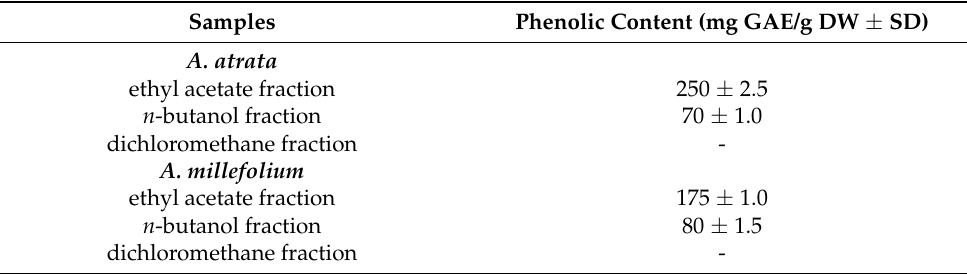
Table 4. Total phenolic content of A. atrata and A. millefolium ( n = 3; ±